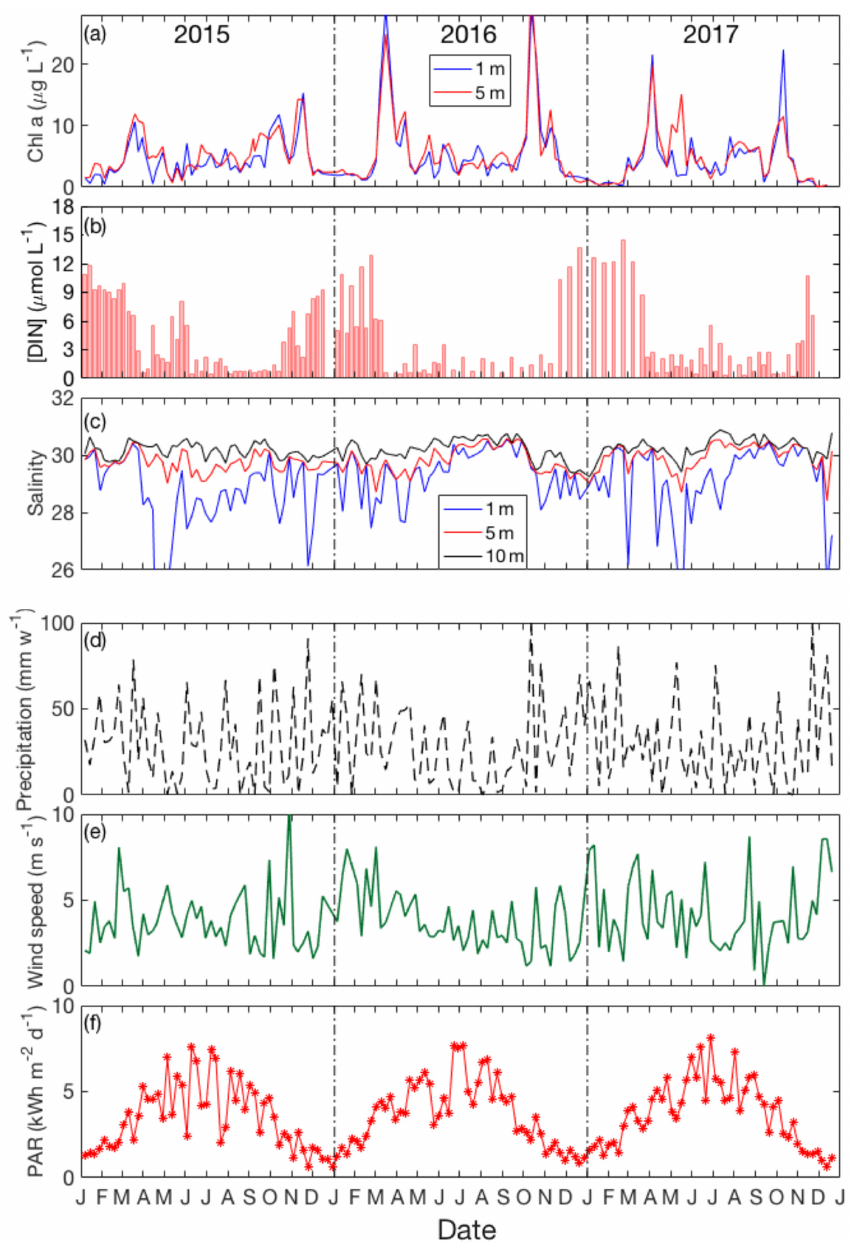
Figure 3. Seasonal variation of (a) chlorophyll a : 1m (blue line) and 5m (red line); (b) DIN; (c) salinity in the surface layer: 1m (blue line), 5m (red line) and 10m (black line); (d) weekly precipitation and (e) daily averaged wind speed (shown here only for sampling days); (f) weekly average PAR from January 2015 to December